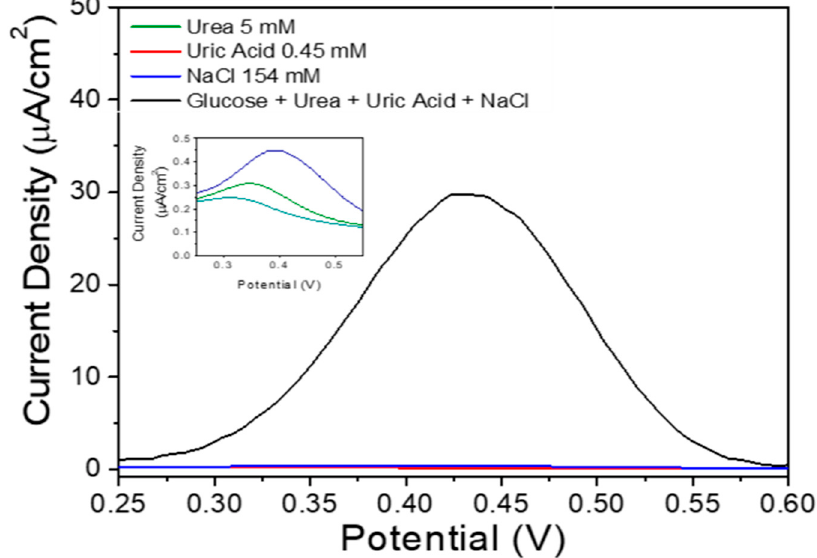
Figure 9. DPV Fe 3 O 4 voltammogram on 154 mM NaCl, 0.45 mM uric acid, 4.50 mM glucose and 5.00 mM urea in 0.1 M of PBS pH